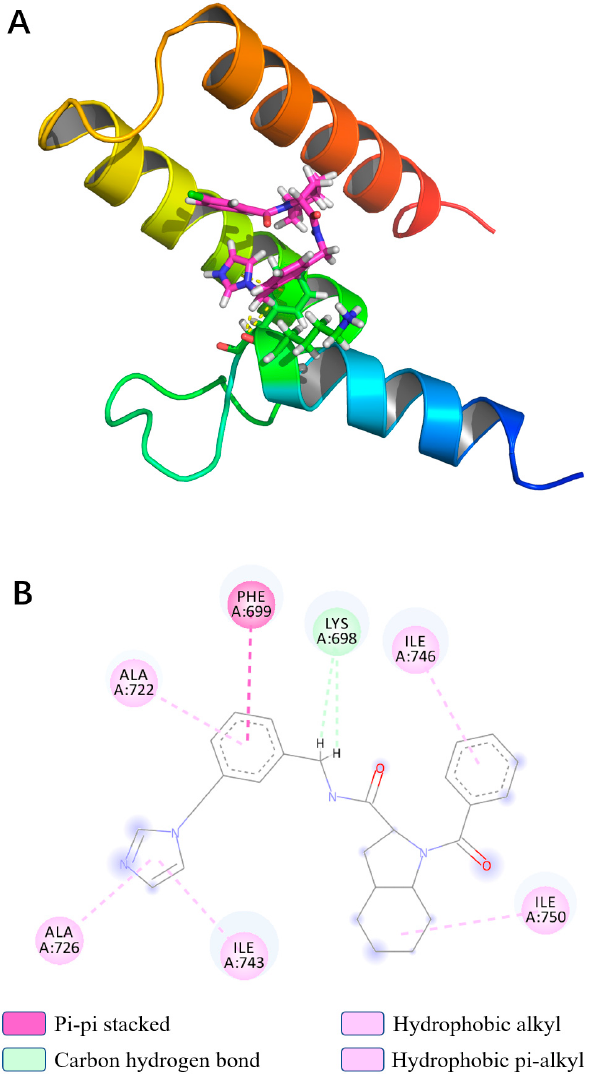
Figure 7. ( A ) Interaction ribbon diagram, magenta: compound 4808; ribbon: PB1 protein; yellow: hydrogen bond; ( B ) two-dimensional protein–ligand contacts of compound 4808 predicted through molecular dynamics.